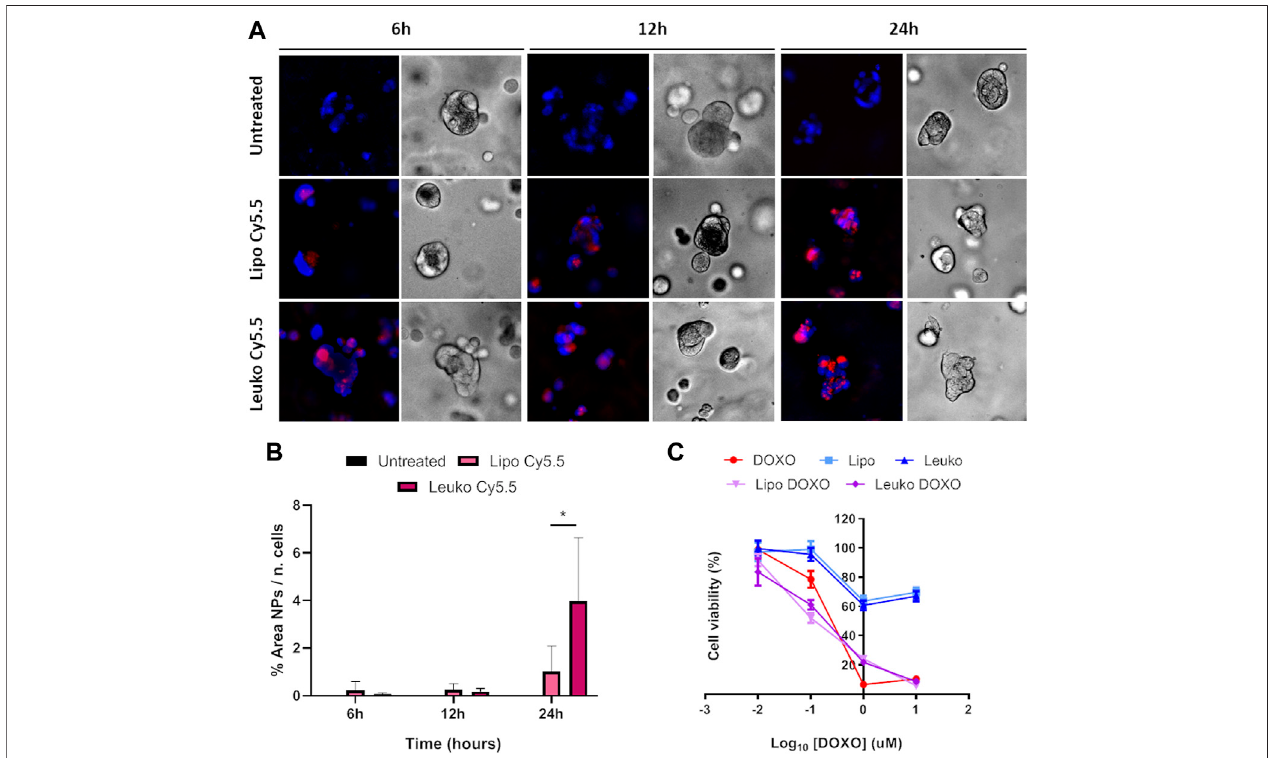
FIGURE 9 | (A) Fluorescence (Fluo) and respective bright fi eld (BF) images of HCT-116 spheroids cultured into Geltrex ™ treated with either Lipo Cy5.5 or Leuko Cy5.5 for 6, 12, and 24 h. (B) Quanti fi cation of Lipo and Leuko fl uorescence at different time points during uptake. (C) Resazurin cell viability assay results for DOXO,